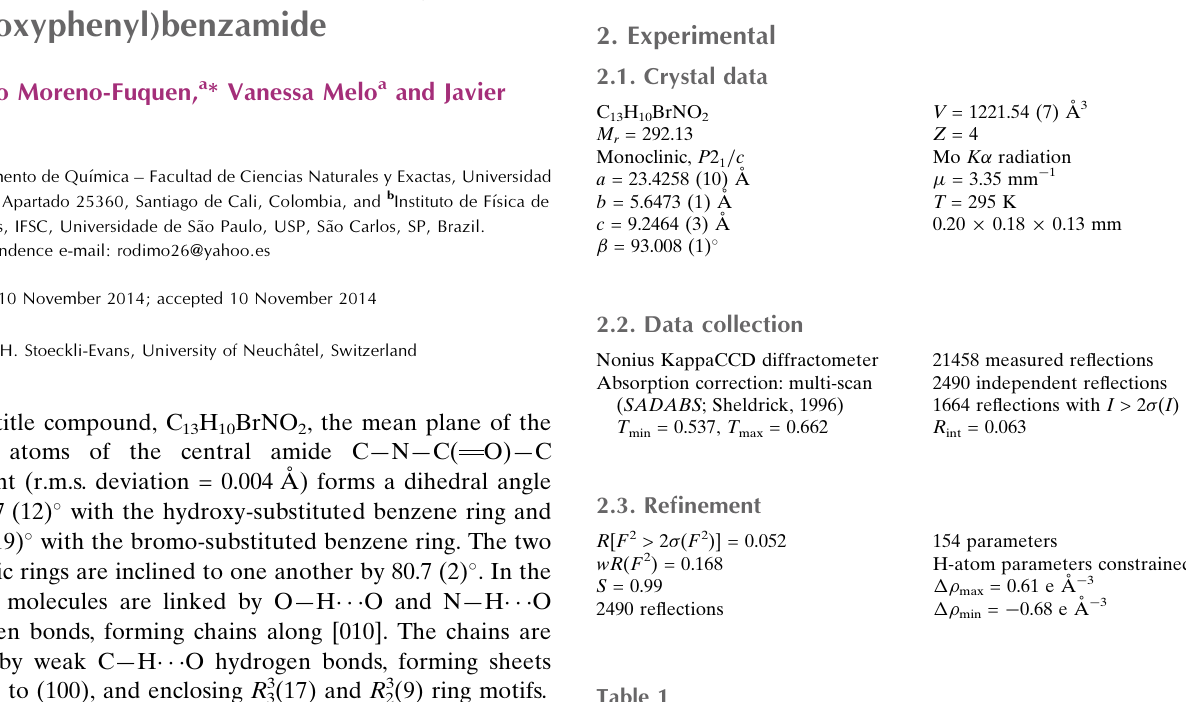
Hydrogen-bond geometry (A˚ , (cid:2)